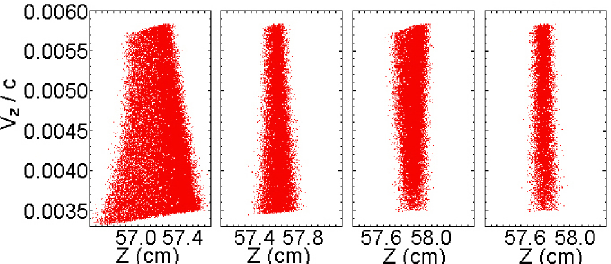
g beam phase space plots for the z